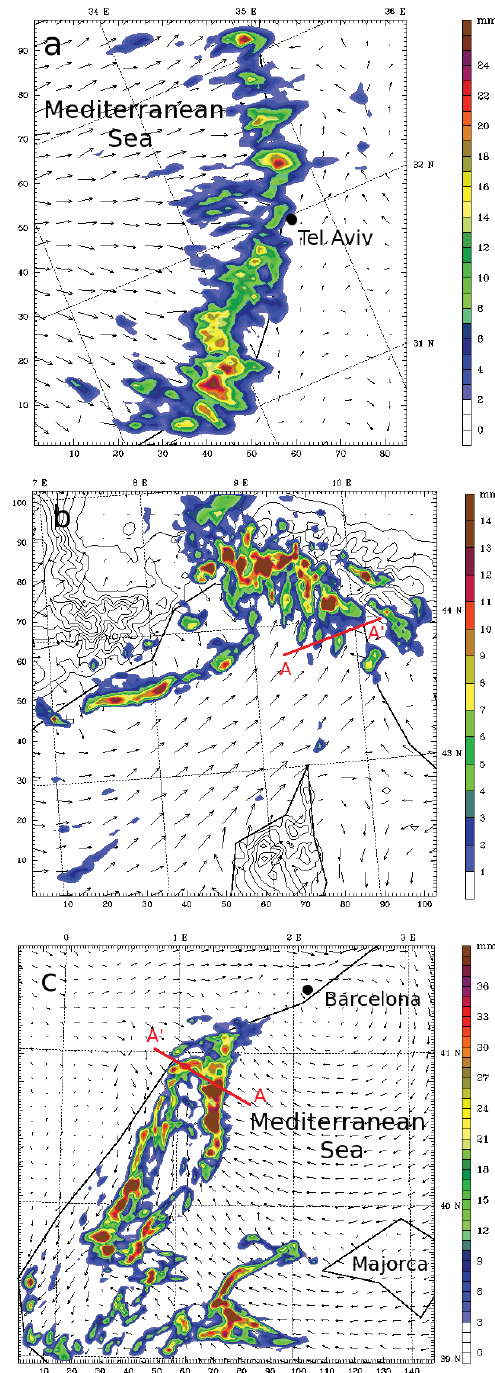
Figure 4. 10h accumulated precipitation (color-filled contours) and surface wind field (vectors) at 10:00UTC on (a) 6 January 2011 for the ISR event (maximum wind vector 6.3ms − 1 ), (b) 30 Jan- uary 2008 for the GEN event (maximum wind vector 11ms − 1 ), and (c) 6 September 2011 for the IP event (maximum wind vector 9ms − 1 ). In (b) and (c) , the red line AA’ indicates the projection of the vertical cross section used to estimate the coastal-front depth. Note that the color scale for precipitation is not the same in the three